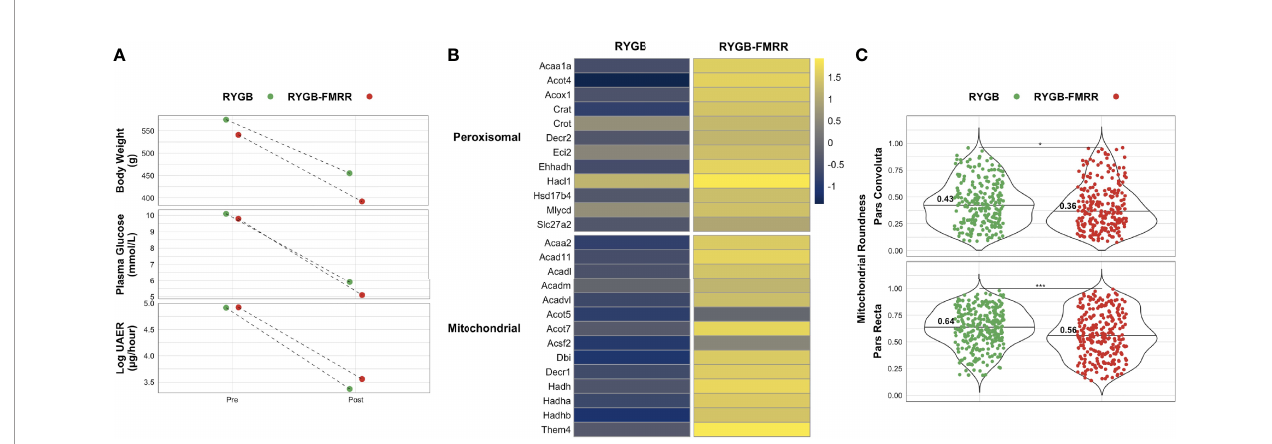
FIGURE 11 | Comparison of renal cortical lipid metabolism parameters between RYGB and RYGB-FMRR rats matched for improvements in metabolic control and urinary albumin excretion. (A) One rat each from the RYGB and RYGB-FMRR groups, matched for body weight, plasma glucose, and albuminuria, was used for a comparative analysis of renal cortical lipid metabolism transcript expression and proximal tubular mitochondrial morphology. Body weight, plasma glucose, and log urinary albumin excretion rate values pre- and post-intervention are plotted, highlighting both similar baseline values and magnitude of improvement in these parameters for each rat from the RYGB and RYGB-FMRR groups. (B) Heatmap of renal cortical peroxisomal and mitochondrial lipid metabolism transcript expression for the matched RYGB and RYGB-FMRR rats, indicating increased relative expression of lipid metabolism transcripts in the RYGB-FMRR rat. Regularized log-transformed gene expression counts from RNA-sequencing, centred and scaled by row, are plotted. Transcripts plotted are those which resulted in enrichment of peroxisomal and mitochondrial lipid metabolism pathways in RYGB-FMRR rats (also highlighted in the circular network plot in Figure 2D ). Heatmap rows display individual transcripts while columns re fl ect values from the matched RYGB and RYGB-FMRR rats. The column gap separates RYGB and RYGB-FMRR rats, while the row gap separates peroxisomal and mitochondrial lipid metabolism transcripts. (C) Mitochondrial roundening was lower in both the pars convoluta and pars recta sections of the proximal tubule in the RYGB-FMRR animal compared with the matched RYGB animal. Mitochondrial roundness in the pars convoluta and pars recta was quanti fi ed using transmission electron microscopy images from each of the matched animals. Mitochondria were quanti fi ed in 15 non-overlapping images captured from 3 distinct pars convoluta and pars recta regions (5 images/region) for each animal. Data are plotted as violin plots with individual mitochondrial measurements superimposed. Median values are identi fi ed by the horizontal black line in each violin and printed on each violin. Statistical signi fi cance of differences in mitochondrial characteristics between the two animals derived from Wilcoxon rank-sum tests is denoted as follows: ns = not signi fi cant; * = p <0.05; ** = p <0.01; *** = p <0.001; **** = p <0.0001. RYGB, Roux-en-Y gastric bypass; RYGB-FMRR, Roux- en-Y gastric bypass plus feno fi brate, metformin, ramipril, and rosuvastatin; UAER, urinary albumin excretion